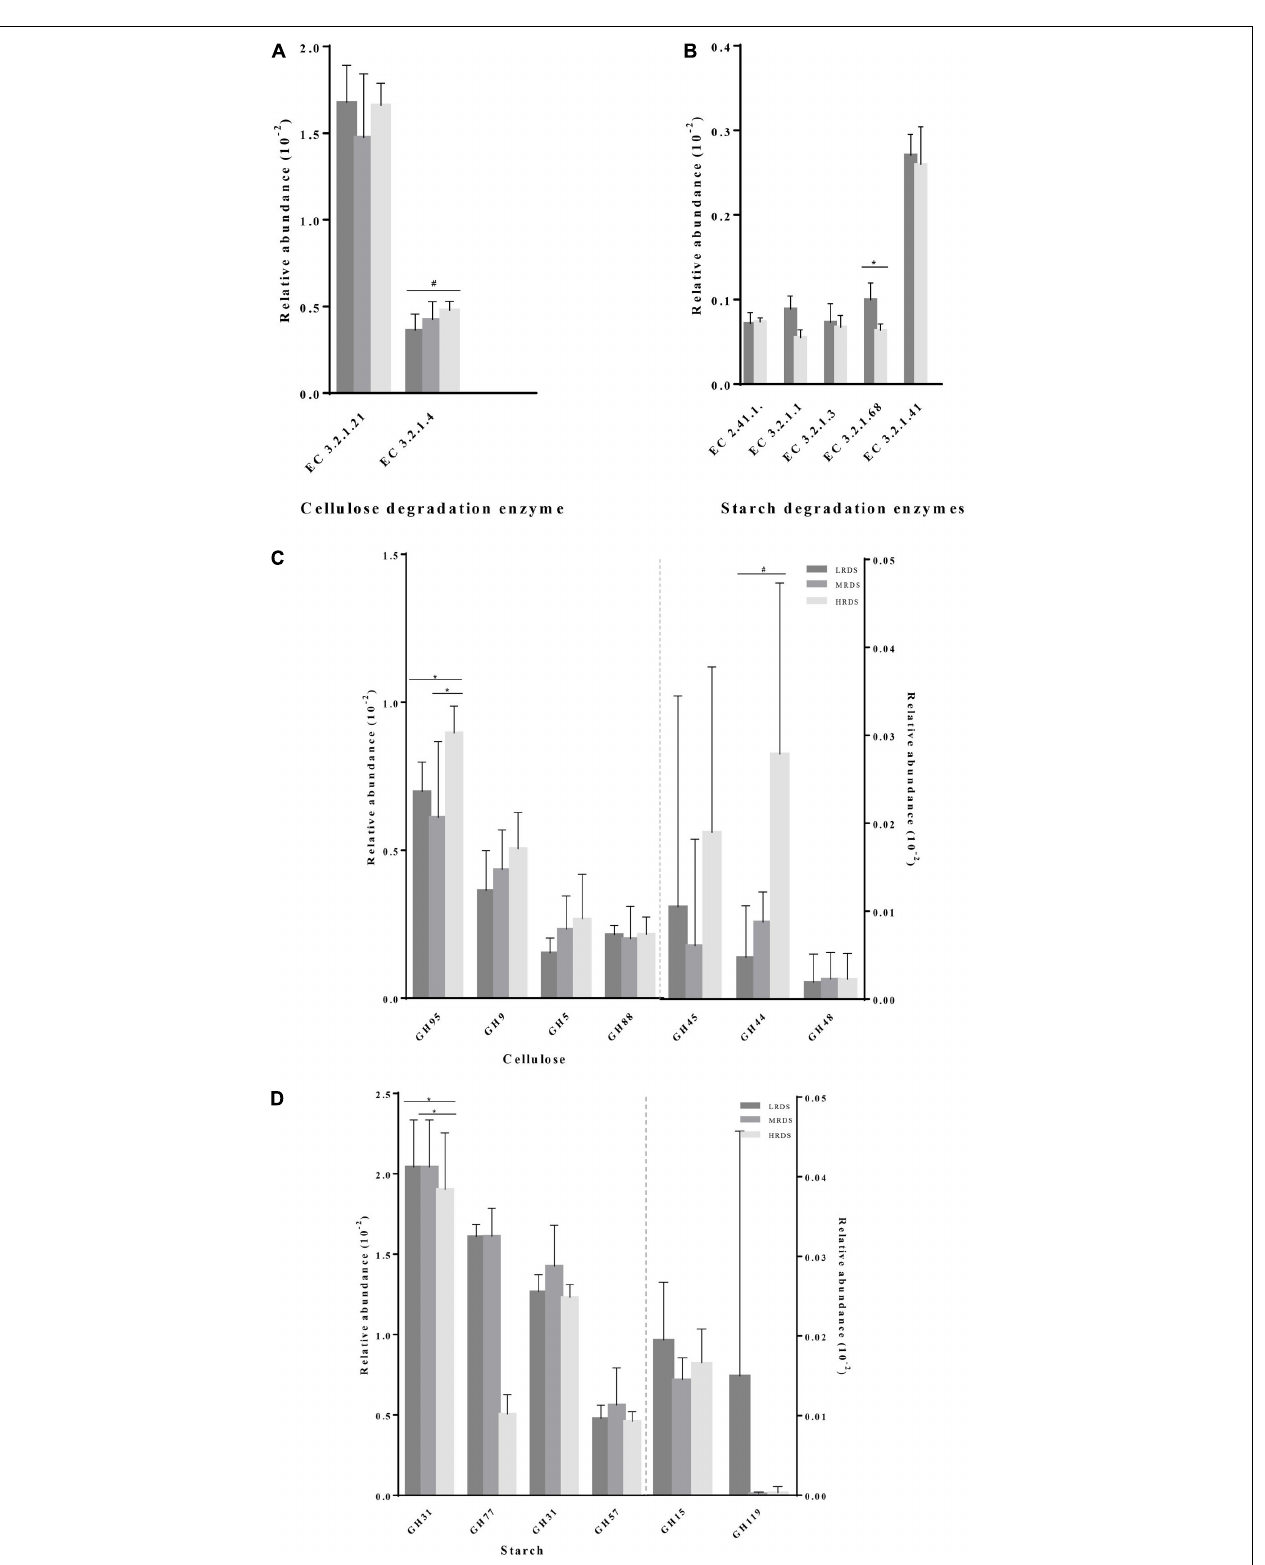
Frontiers in Microbiology |